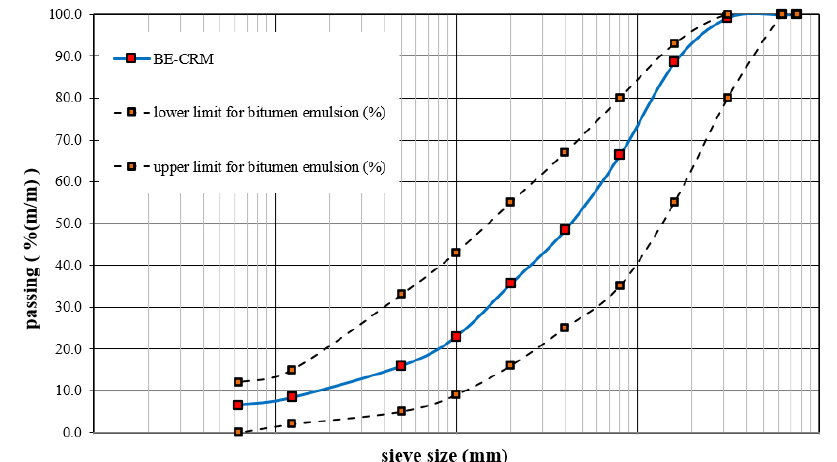
Figure 1. Granulation curve for the mineral mixture included in the BE-CRM.